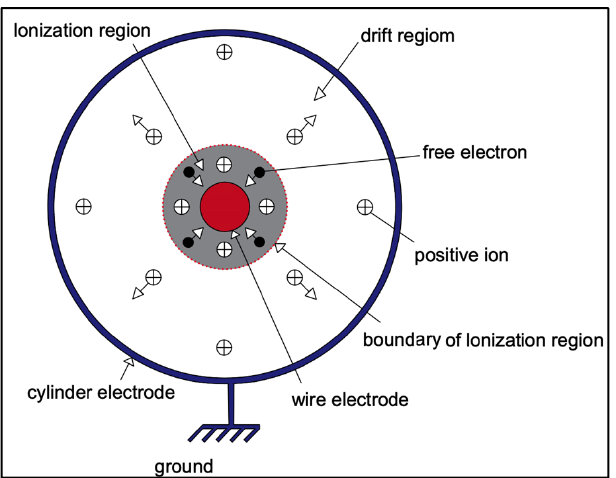
Figure 1. Schematic of positive corona discharge in coaxial wire–cylinder electrode geometry.